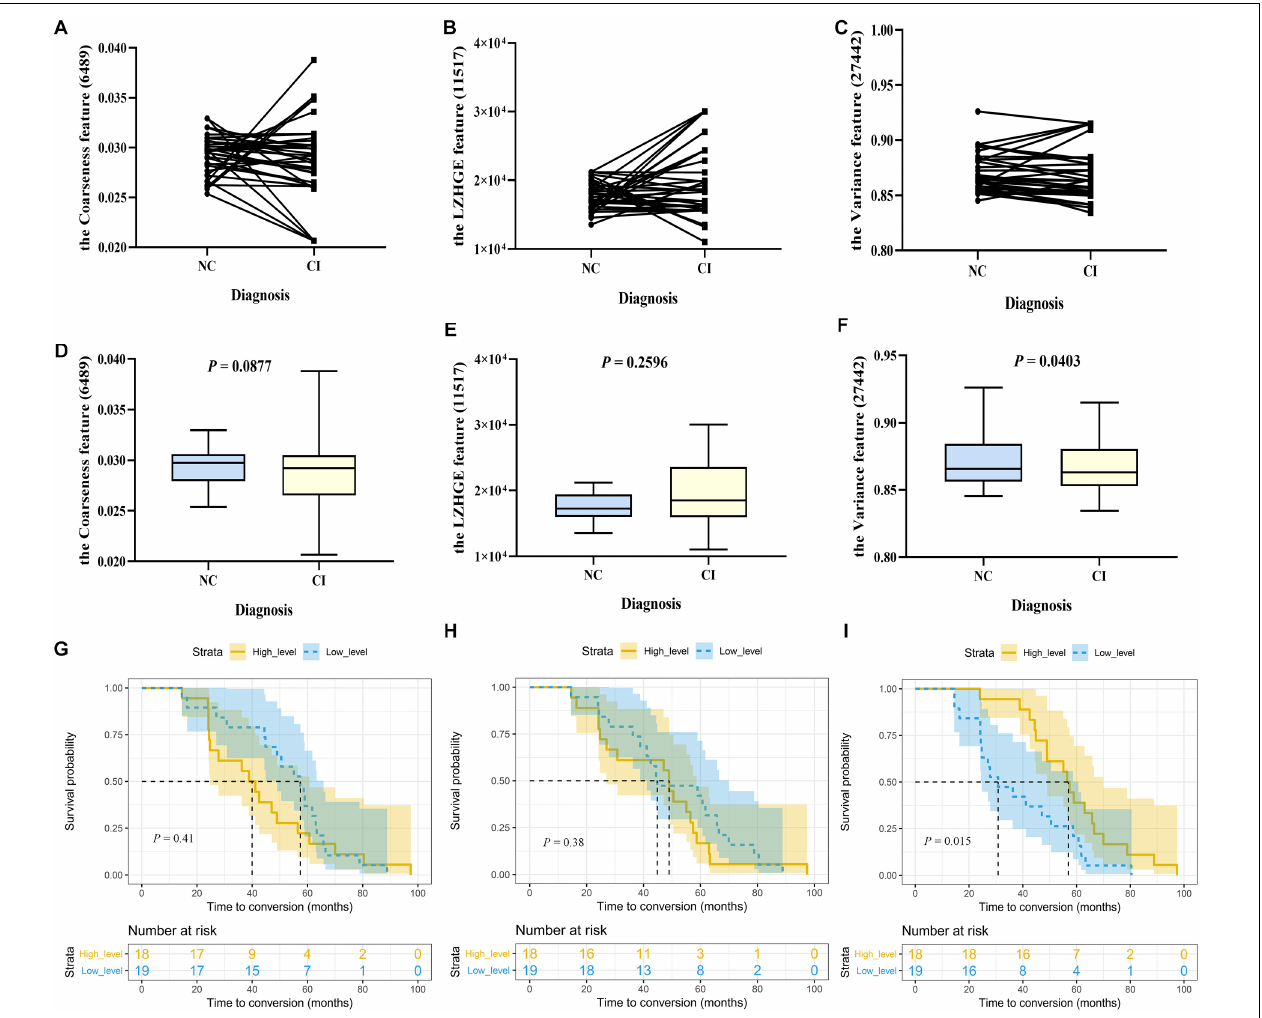
FIGURE 3 | The longitudinal changes and survival analyses of stable high-frequency features. In Study 2, 37 participants were included. Their cognition was normal at baseline and impaired during follow-up, with two progressing to dementia and 35 to mild cognitive impairment. We compared the levels of each stable high-frequency feature between the two time points. (A–C) Show the changing trajectory at the individual level; (D–F) are at the group level, with paired two-sample t -tests (two-tailed, p < 0.05). Furthermore, these individuals were stratified into high-level ( n = 18) and low-level group ( n = 19) groups by the baseline median level of each stable high-frequency feature. (G–I) Show Kaplan–Meier curves demonstrating the cumulative probabilities of conversion of the two groups (shaded area represents the 95% confidence interval); differences are displayed by log-rank tests ( p < 0.05). Only feature 27,442 was different at the two time points ( p = 0.0403), and its low-level group had a shorter conversion time than the high-level group ( p = 0.015). The features were the coarseness feature of the left posterior cingulate gyrus on sMRI (ID: 6489; A, D, G ), the LZHGE feature of the right posterior cingulate gyrus on sMRI (ID: 11517; B, E, H ), and the variance feature of the left superior parietal gyrus on sMRI (ID: 27442; C, F, I ). NC, normal control; CI, cognitive impairment; sMRI, structural magnetic resonance imaging; LZHGE, large zone high-gray-level